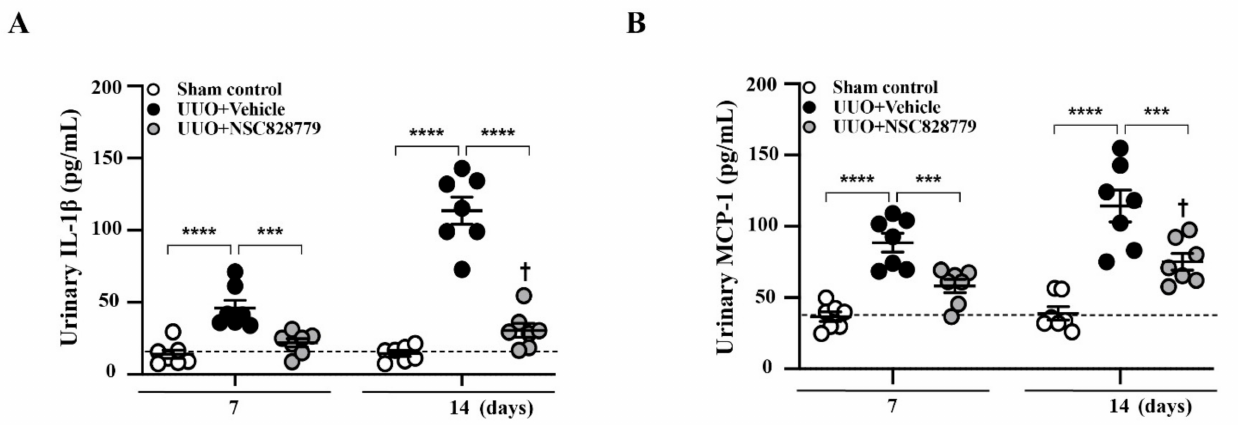
Figure 1. NSC828779 reduces urine levels of proinflammatory cytokines. ELISA analysis of urine protein levels of ( A ) IL-1 β , and ( B ) MCP-1 collected from the dilated pelvis. The horizonal dashed line indicates the mean for sham control + NSC828779. Data are shown as means ± SEM of seven mice per group. NSC828779, a salicylanilide derivative. UUO, unilateral ureter obstruction. *** p < 0.005, **** p < 0.001. † p < 0.05 Day 7 versus Day14 of UUO +